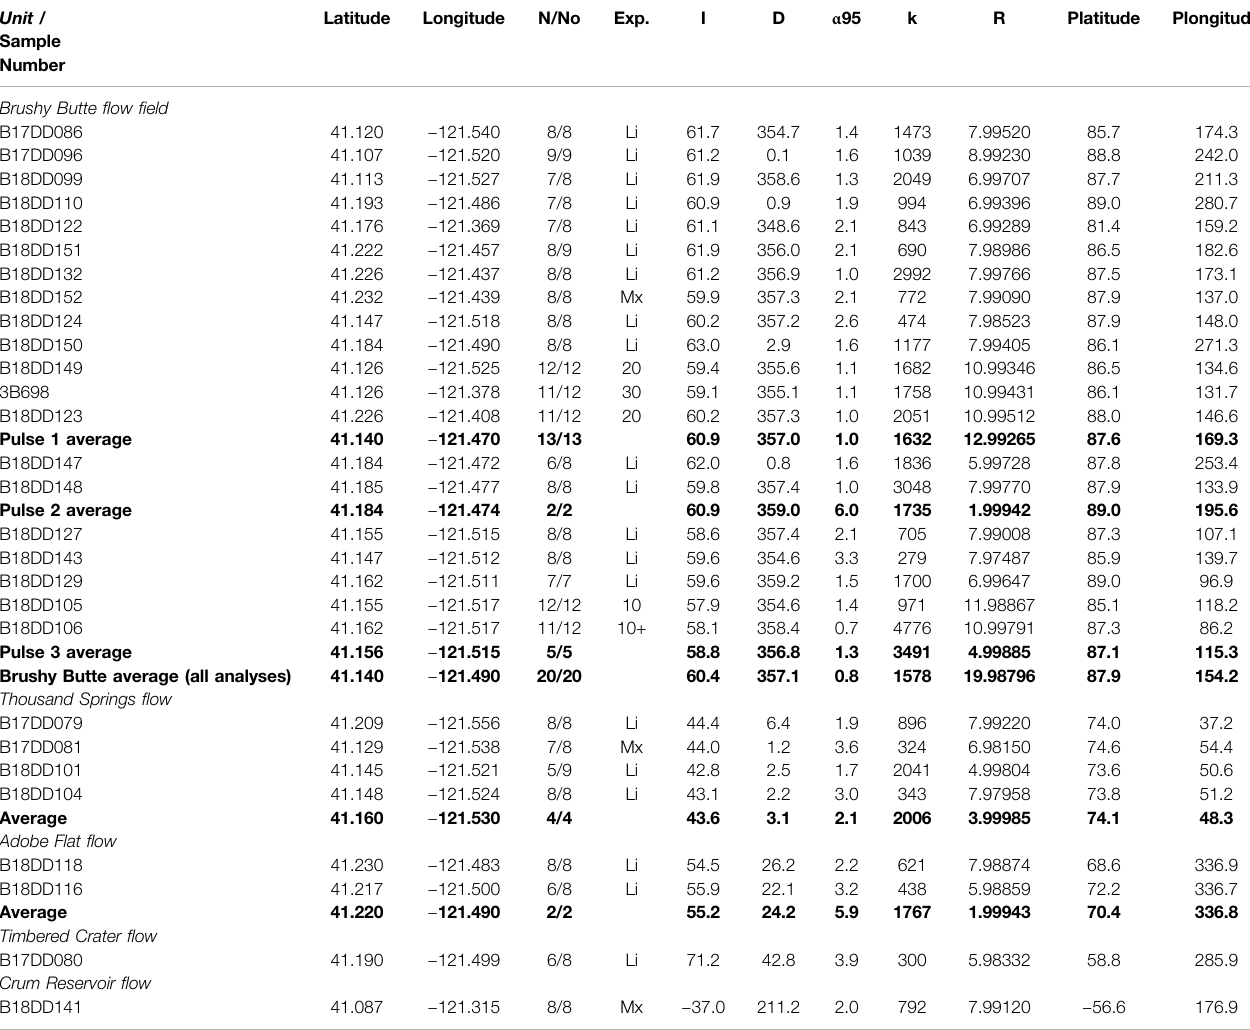
Latitude Longitude N/No